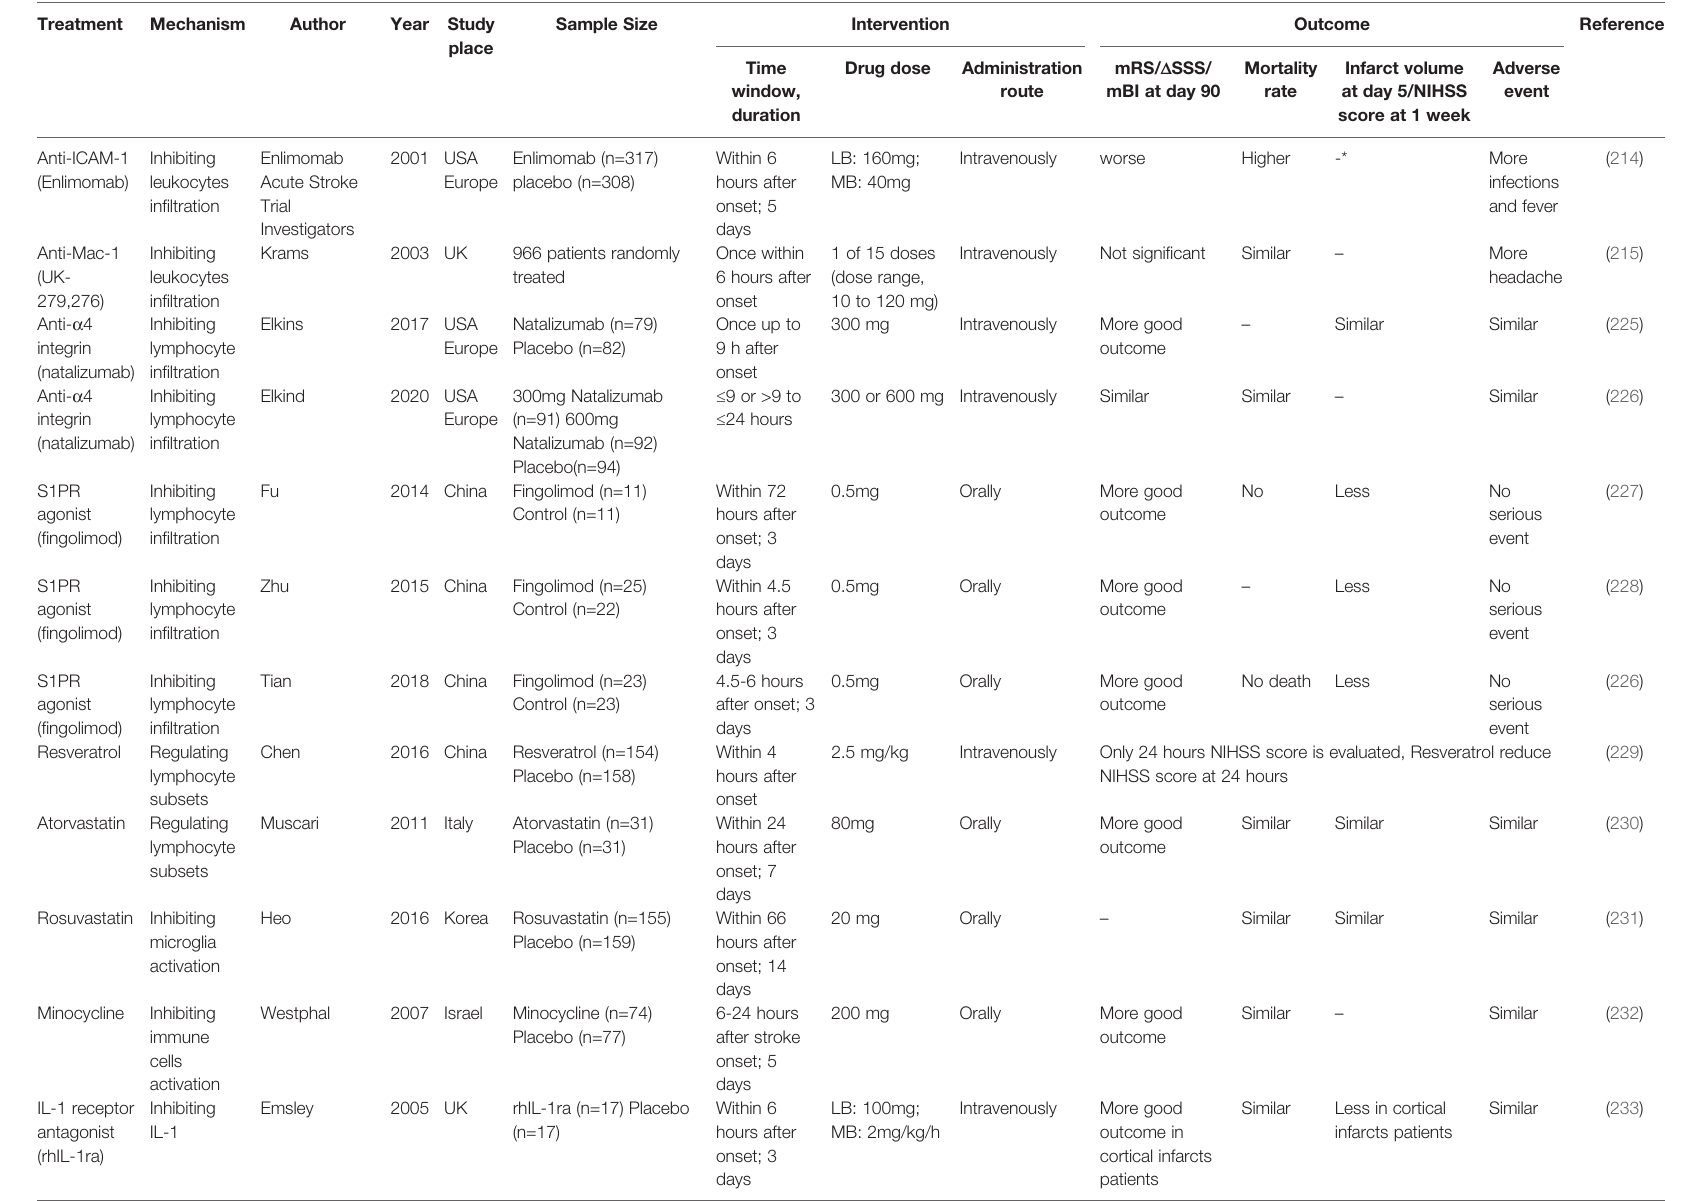
TABLE 2 | Randomized controlled trials targeting immune cells in human ischemic